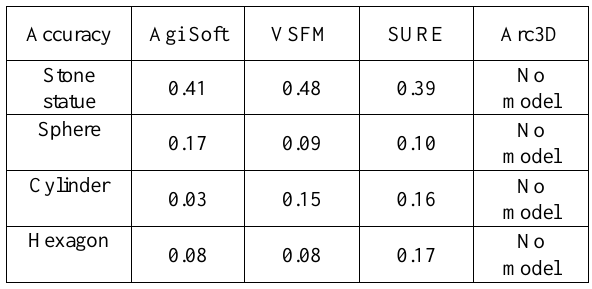
Table 2- Accuracy for Iphone5 sensor